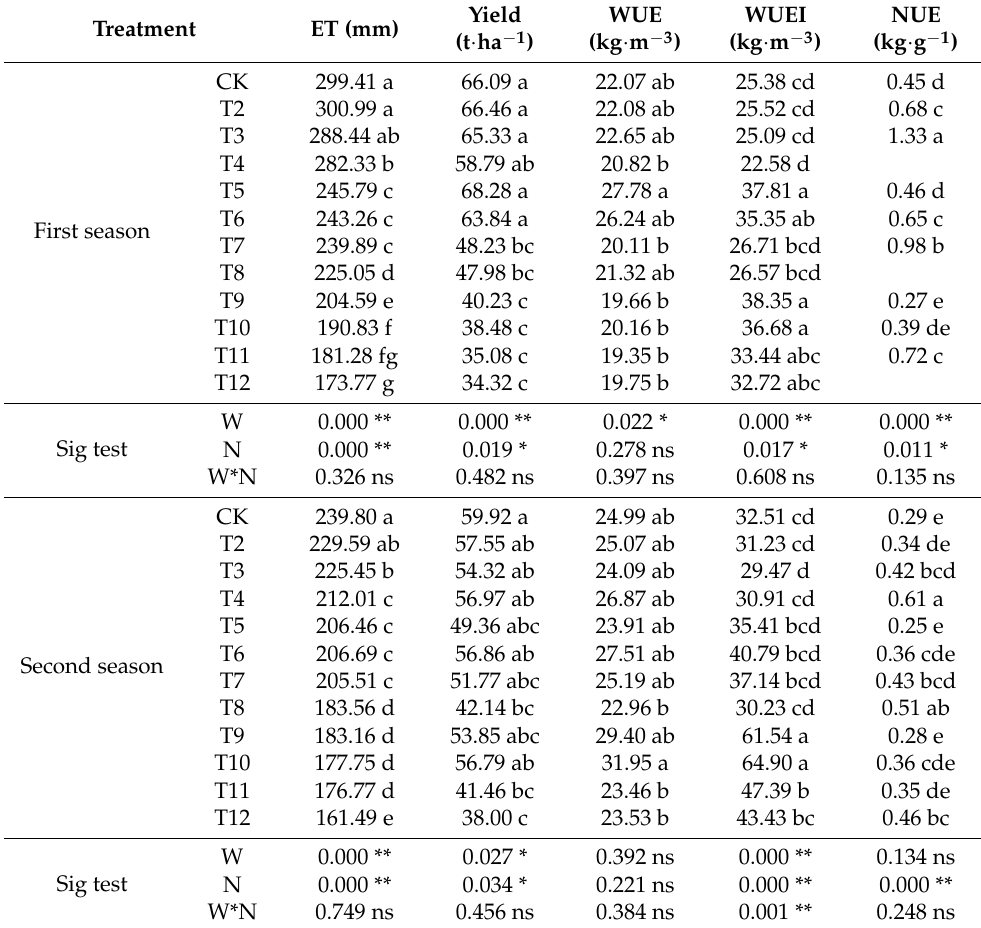
Table 2. Evapotranspiration (ET), yield and product efficiency (WUE, WUEI and NUE) under different water and nitrogen treatments in the first and second seasons of